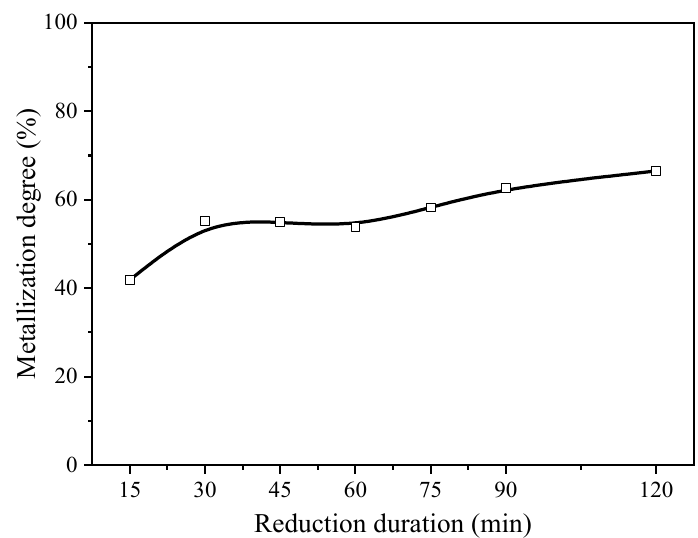
Figure 5. Effect of reduction duration on metallization of reduced pellets of high-aluminum iron ore (HA ore) (reducing at 1050 °C with C/Fe mass ratio of 1.5).